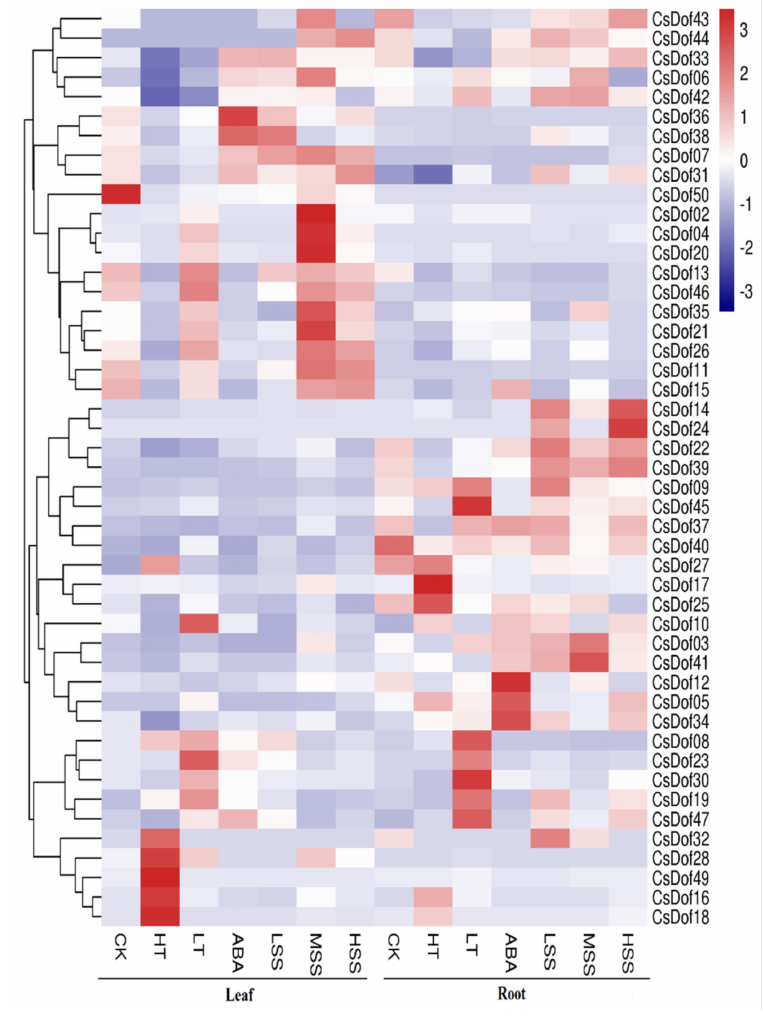
Figure 6. Heat map representation of CsDof genes across different treatments in leaf and root at 0 h and 24 h. CK: denotes 0 h. HT: high temperature (40 ◦ C), LT: low temperature, ABA: ABA (100 µ M), LSS: 50 mM NaCl (light salt stress), MSS: 100 mM NaCl (moderate salt stress), and HSS: 200 mM NaCl (high salt stress), respectively. The color scale represents FPKM